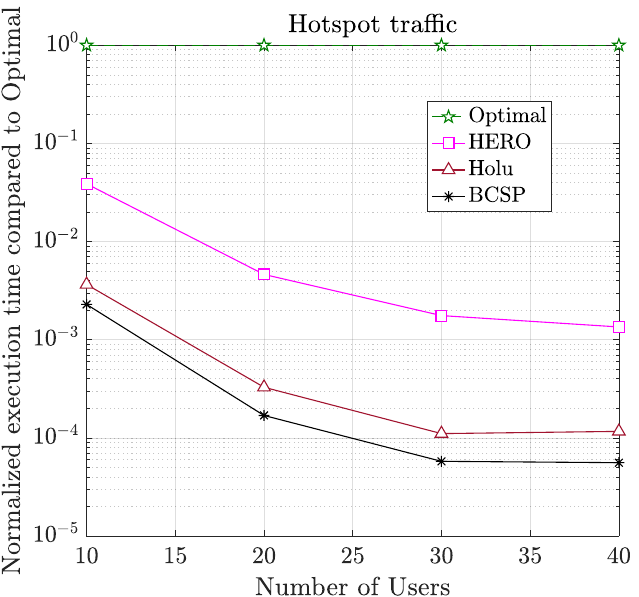
Figure 7. Execution time (s) in logarithmic scale of all algorithms for different numbers of UEs per gNB